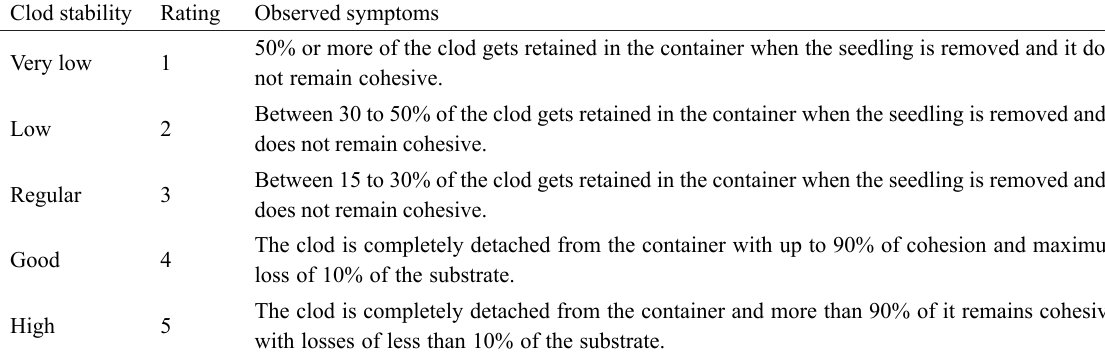
Table 2 Rating scale proposed to assess the clod stability (CS) of the three pepper genotypes developed on organic